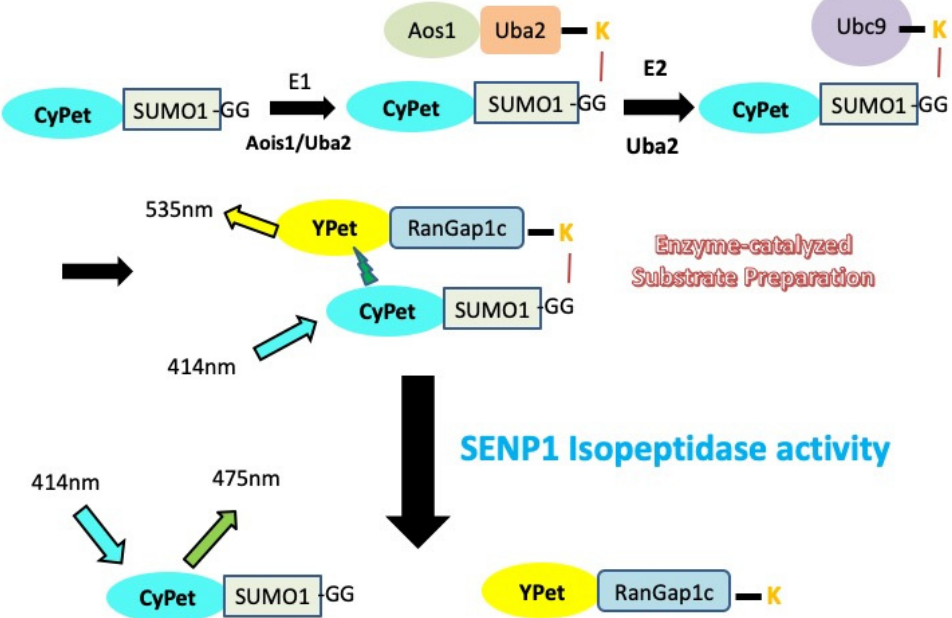
Figure 1. Principle of FRET-based protein assay to monitor the SUMO-RanGAP1C conjugation and deconjugation in vitro .